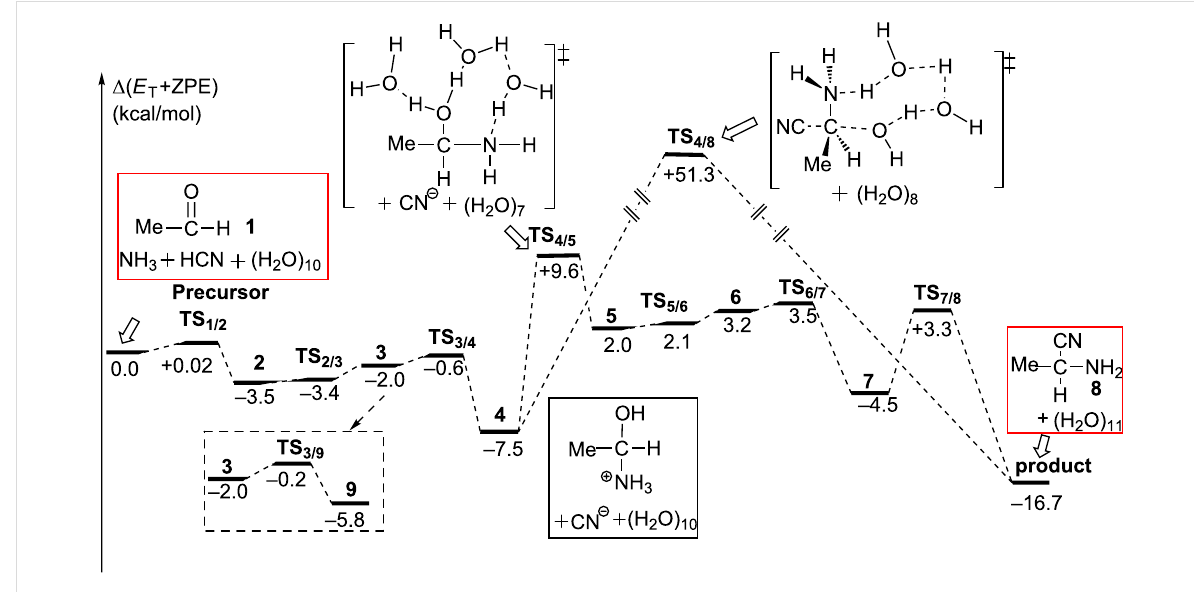
MeC(H)=NH 2 + at the plane opposite to the OH 2 dissociating side (see Scheme 7). The addition model of TS 1/2 was exam- ined by the use of the amine in Scheme 2. The activation energy of the less crowded TS 1/2 –A is 1.8 kcal/mol smaller than the more crowded TS 1/2 –B ; see Figure 3. This calculation result is consistent with Harada's work that a chiral product [4] was obtained in the Strecker reaction.